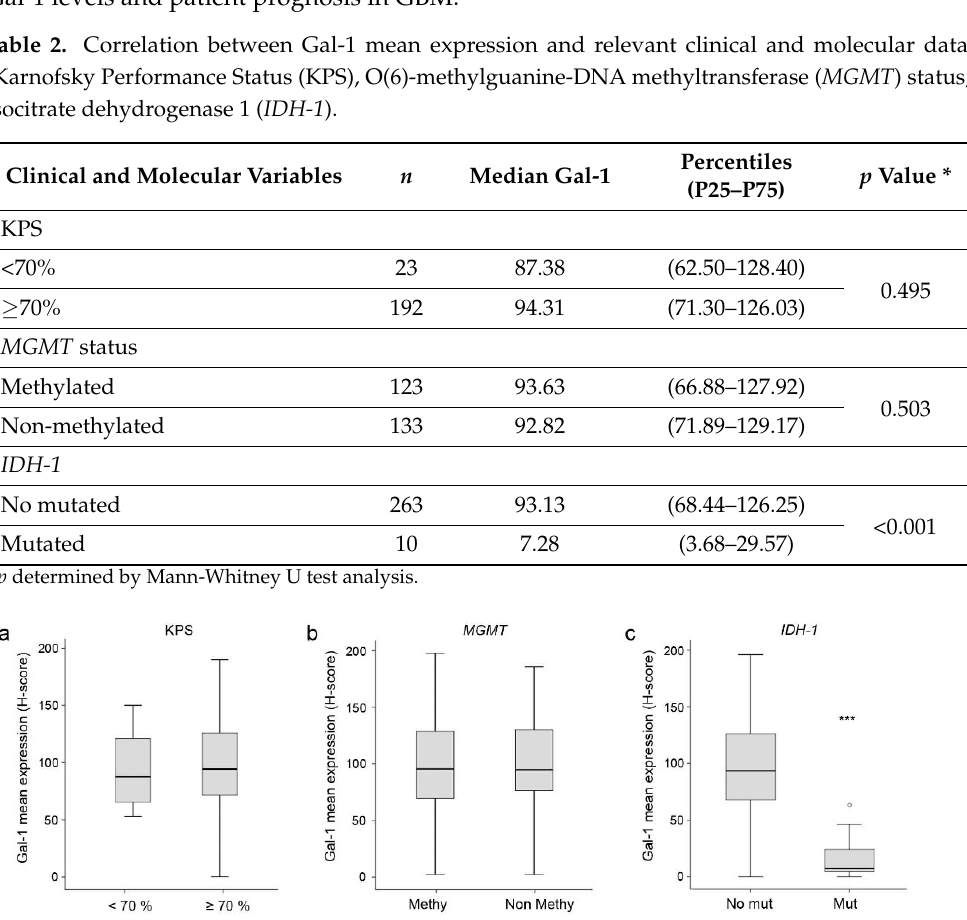
Figure 3. Correlation between mean Gal-1 expression and Karnofsky Performance Scale (KPS) ( a ), MGMT promoter methylation ( b ), or IDH-1 status ( c ). *** p (Mann-Whitney U test) <